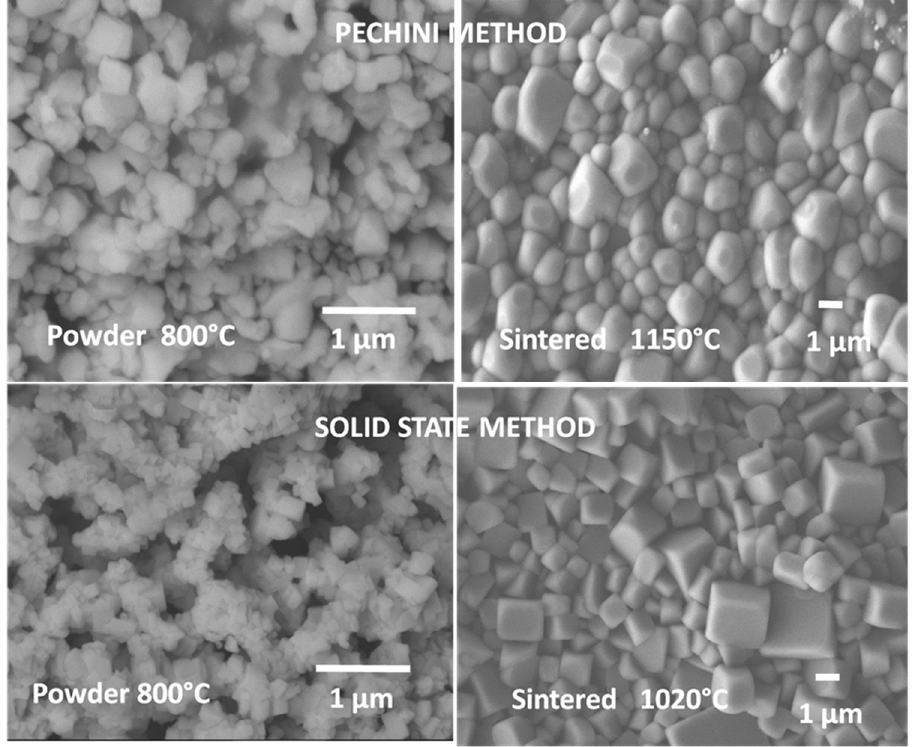
Figure 7. SEM micrographs of synthesized powder (by solid state route and Pechini method) and sintered ceramics of (1 ‐ x )Bi 0.5 Na 0.5 TiO 3 ‐ x Ba 0.9 Ca 0.1 TiO 3 ( x = 0.06) composition. Note the influence of the powder particle morphology on the ceramics’ microstructure.